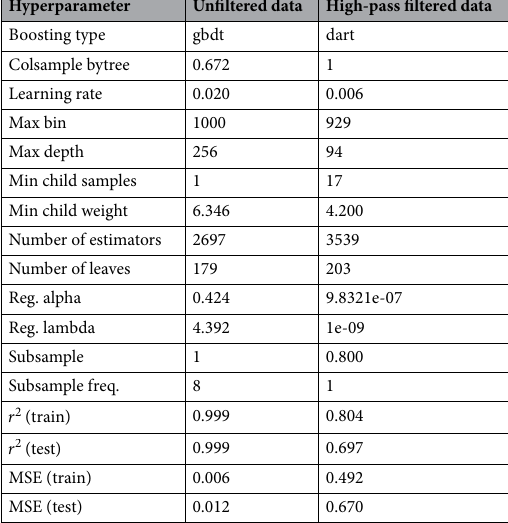
Table 1. The hyper-parameters for each LGMB regressors for unfiltered and high-passed